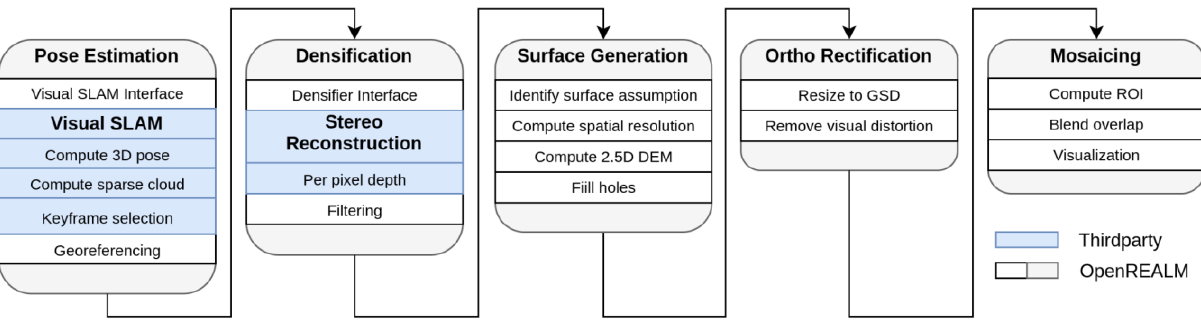
Figure 1 Structure of OpenREALM. It follows a pipeline design, separating different tasks into individual stages that are processed in parallel. An incoming frame moves from left (Pose Estimation) to right